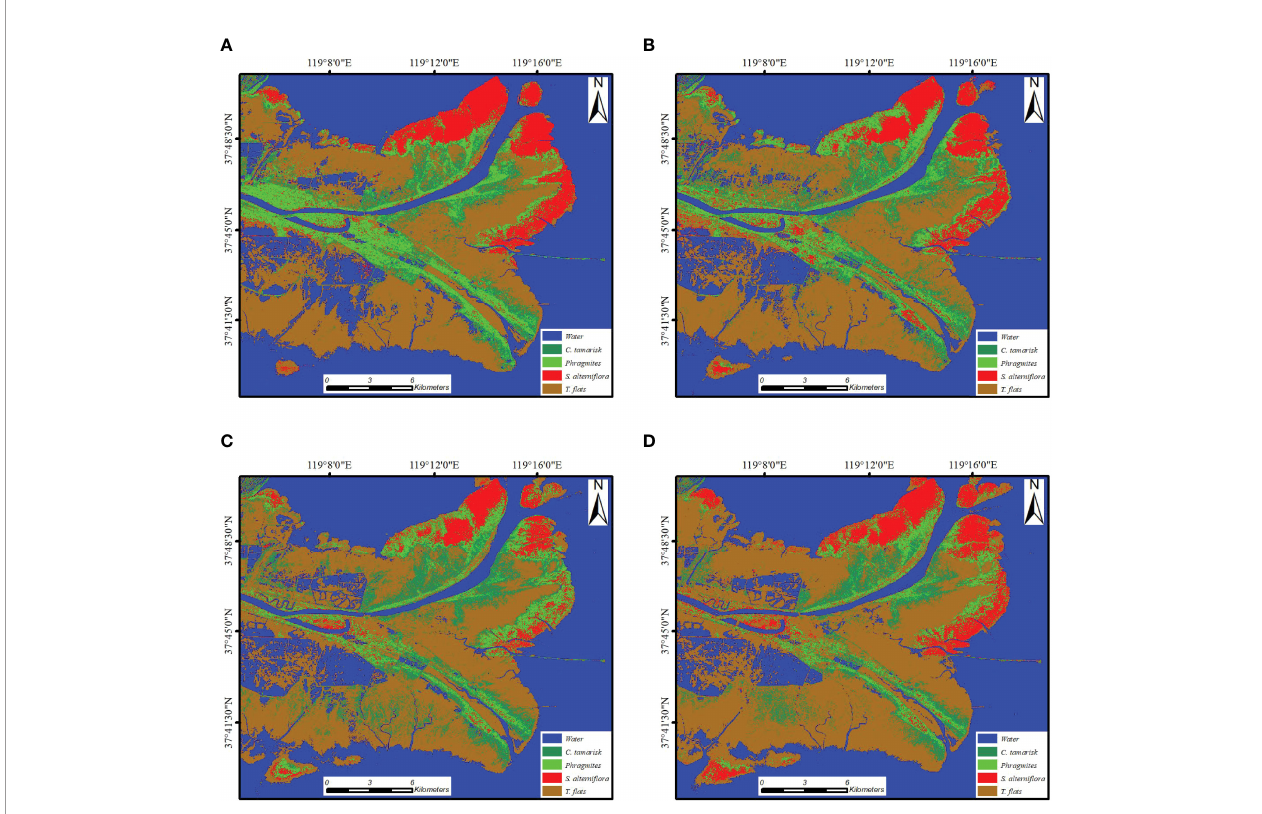
FIGURE 9 | Classi fi cation results of the Yellow River Delta wetlands from 2018 to 2021 based on the decision tree constructed in this paper. (A) is classi fi cation result in 2018; (B) is classi fi cation result in 2019; (C) is classi fi cation result in 2020; (D) is classi fi cation result in